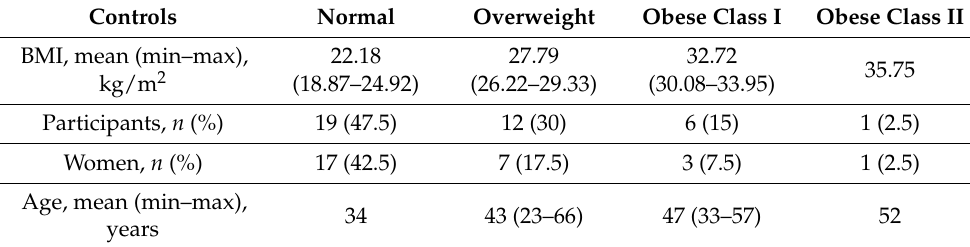
(Table 2). In the control group, ≈ 48% were normal weight (mean 22.18 kg/m 2 ), 30% overweight (mean 27.79 kg/m 2 ), 15% classified as obesity class I (mean 32.72 kg/m 2 ), ≈ 3% as obesity class II (mean 35.75 kg/m 2 ), and 5% as non-reported BMI (Table 3). The analysis of thrombosis versus control group based on BMI showed a significant difference ( p = 0.038). Table 3. Characteristics of controls in relation to